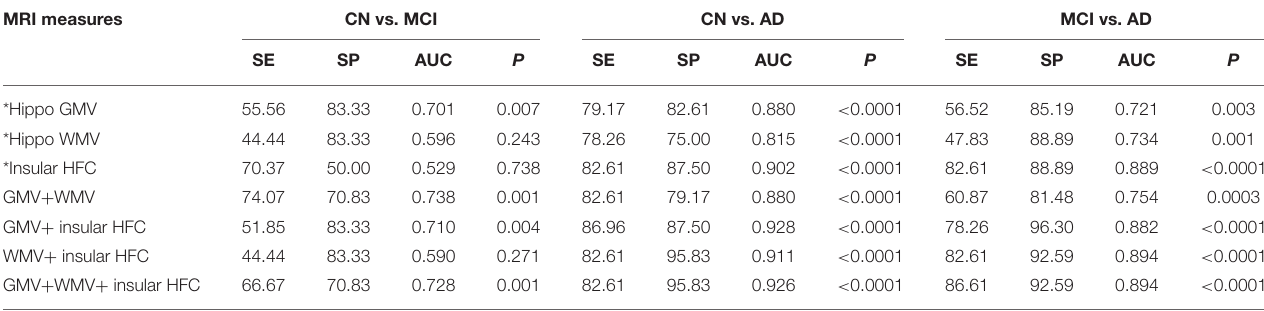
TABLE 4 | Results of receiver operating characteristic (ROC) curve analysis to evaluate the addition of high-frequency conductivity (HFC) index values to the GMV and WMV values for group classifications. MRI measures CN vs. MCI CN vs.